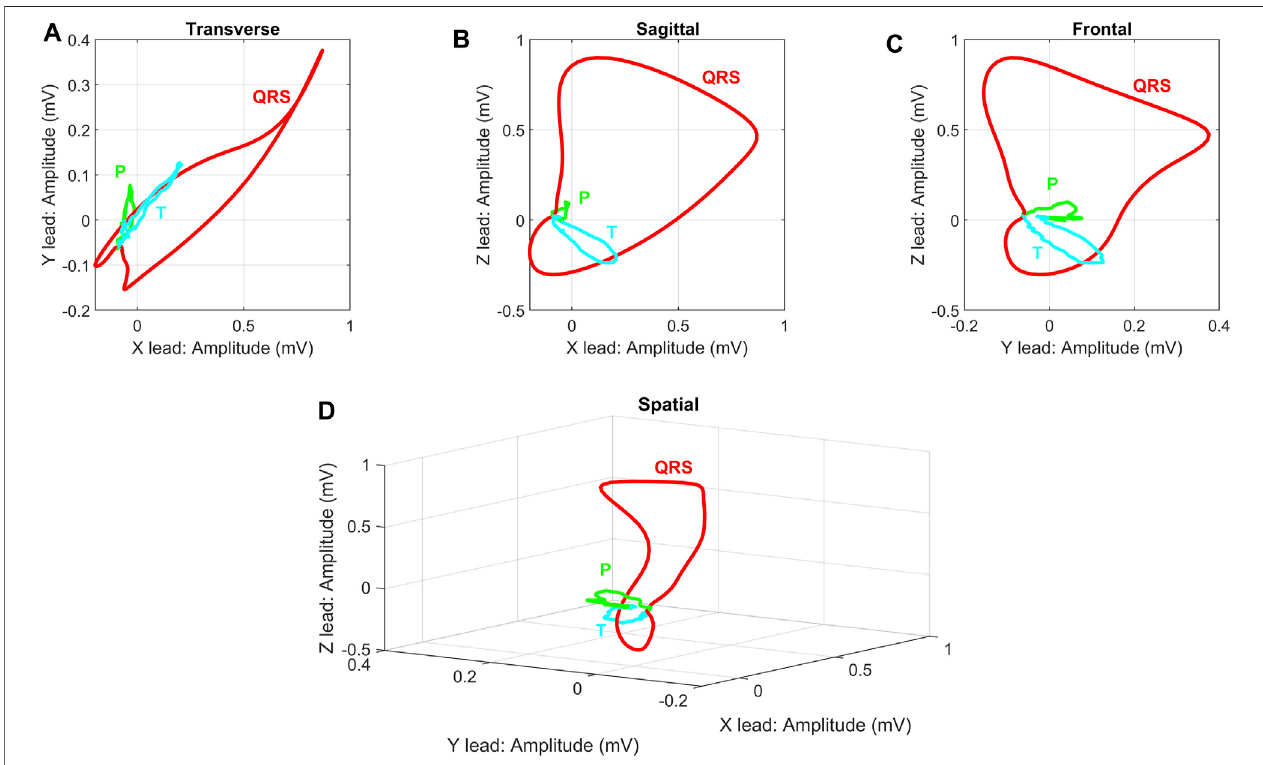
FIGURE2| Demonstration display ofindividualVCG planes forrandomlyselectedphysiological record: (A) Transverseplane ofXand Y leads, (B) Sagittalplaneof X and Z leads, (C) Frontal plane of Y and Z leads, (D) 3-D image of X, Y and Z leads. The record s 0503 rem from the PhysioNet PTB database was used as a randomly selected physiological record. The individual planes are related to the basic principle of VCG measurement on ideal uniform lead fi elds from Figure 2 .